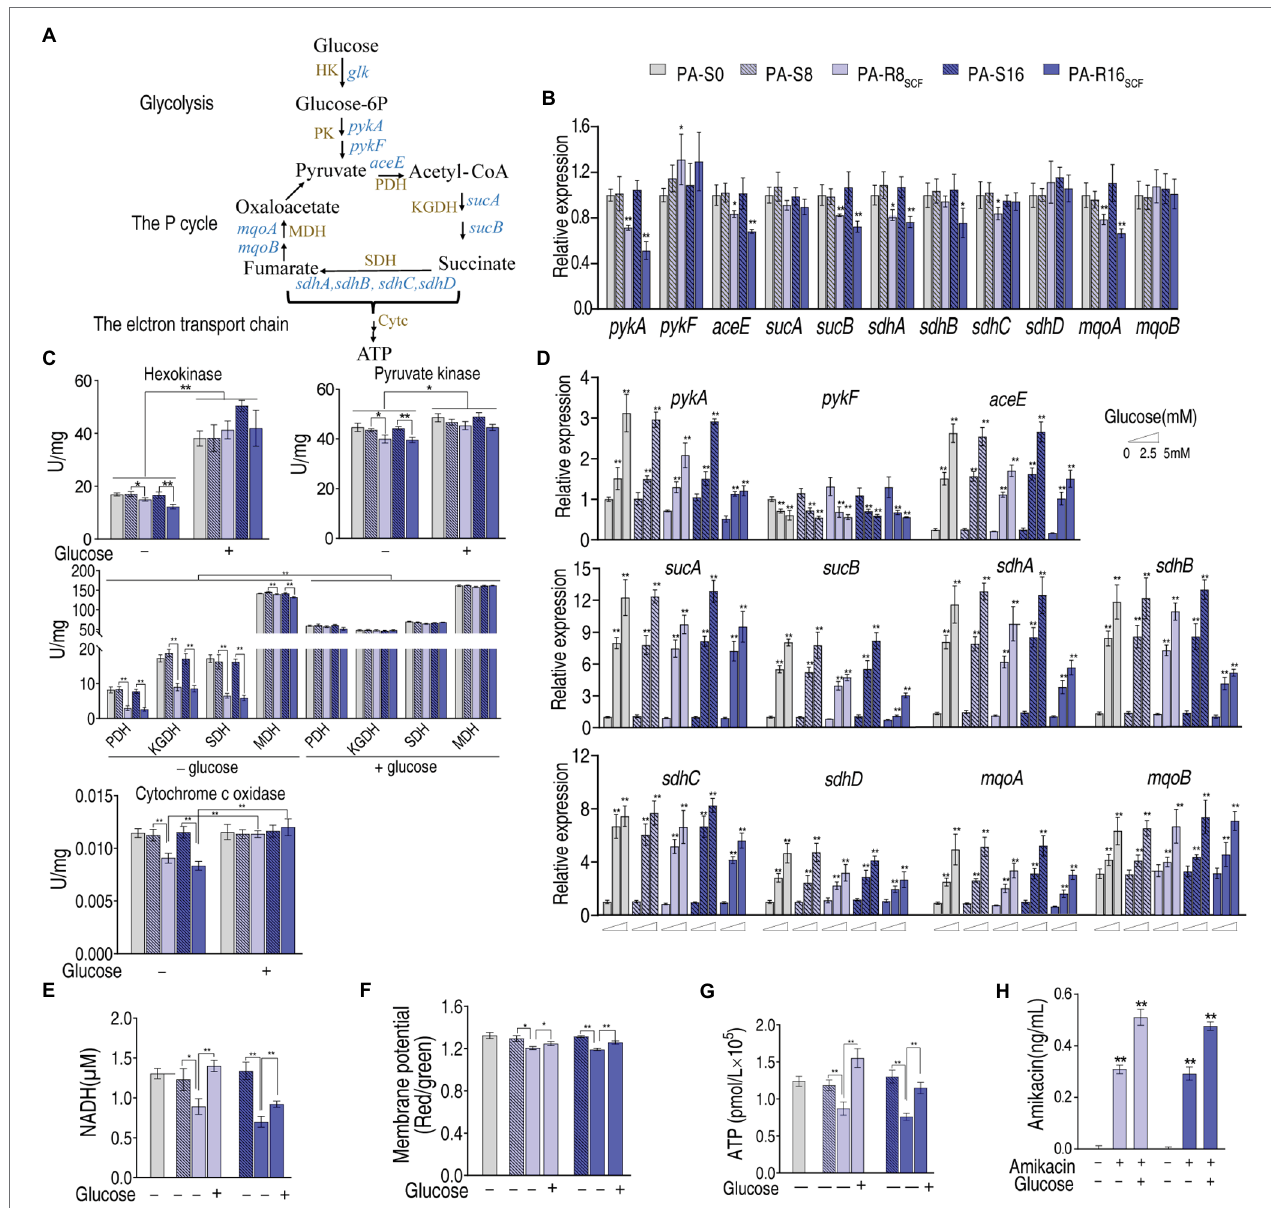
FIGURE 7 | Glycolysis, the P cycle, electron transport chain with and without exogenous glucose in PA-R8 SCF and PA-R16 SCF . (A) Metabolic diagram of glycolysis, the P cycle, electron transport chain. (B) qRT-PCR for expression of genes encoding glycolysis and the P cycle between PA-R8 SCF , PA-R16 SCF , and PA-S8, PA-S16, respectively. (C) Activity of enzymes in glycolysis, the P cycle, electron transport chain between PA-R8 SCF , PA-R16 SCF , and PA-S8, PA-S16, respectively, in the presence or absence of different concentrations of glucose. (D) qRT-PCR for expression of genes encoding glycolysis and the P cycle between PA-R8 SCF , PA- R16 SCF , and PA-S8, PA-S16, respectively, in the presence of different concentrations of glucose. (E–H) NADH (E) , membrane potential (F) , ATP (G) , and amikacin (H) of the two PA-R and three PA-S strains in the presence or absence of glucose. Results are displayed as mean ± SEM, and at least three biological repeats are performed. Significant differences are identified * p < 0.05, ** p <